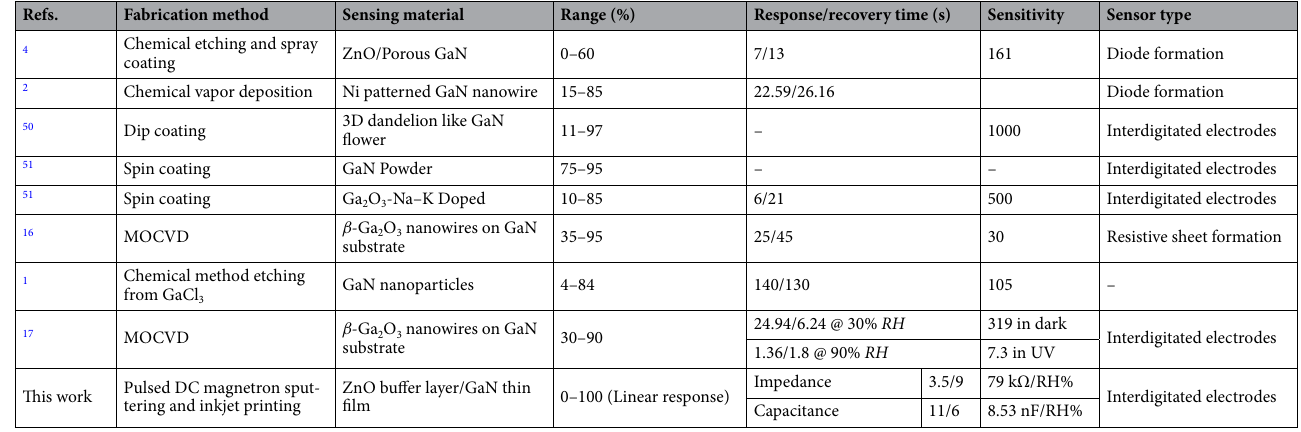
Table 1. Comparison table of GaN humidity